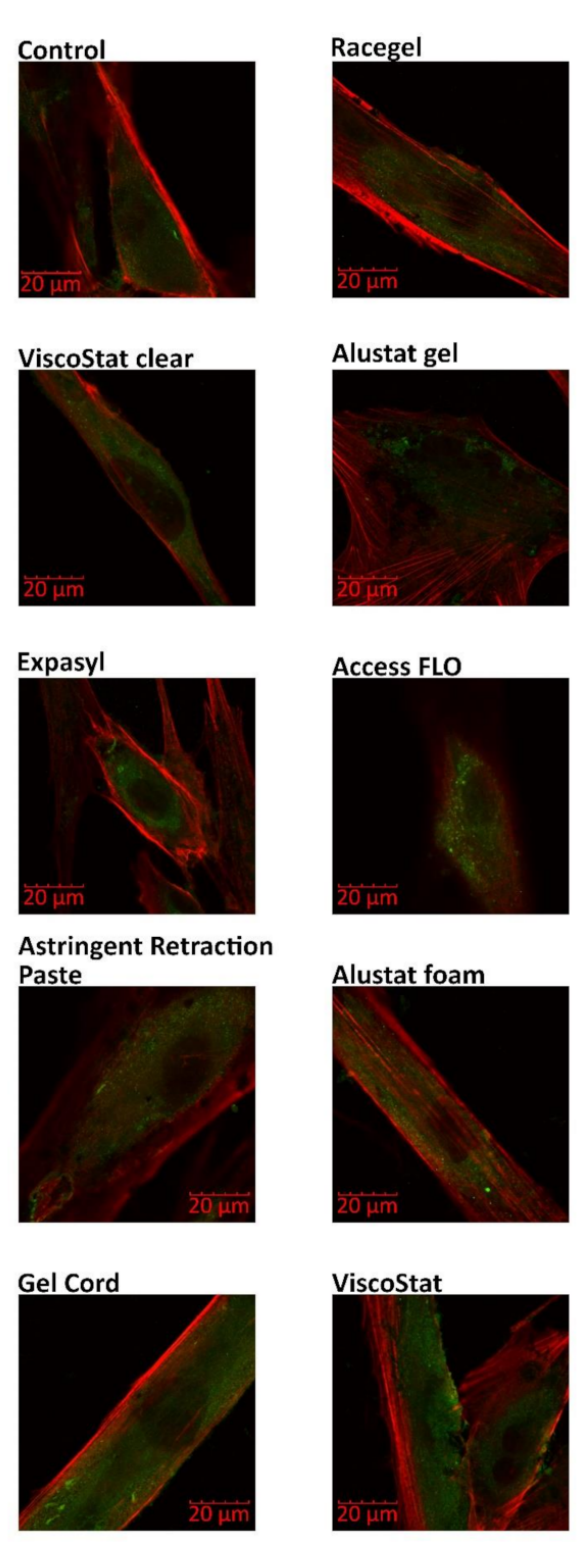
Figure 3. Confocal microscopy evaluation of zyxin and F-actin distribution in human gingival fibroblasts after 24 h of incubation with the gingival retraction agents diluted in the cell culture medium to 1 mg/mL concentration; green colour—zyxin, red colour—F-actin; magnification: 60 ×